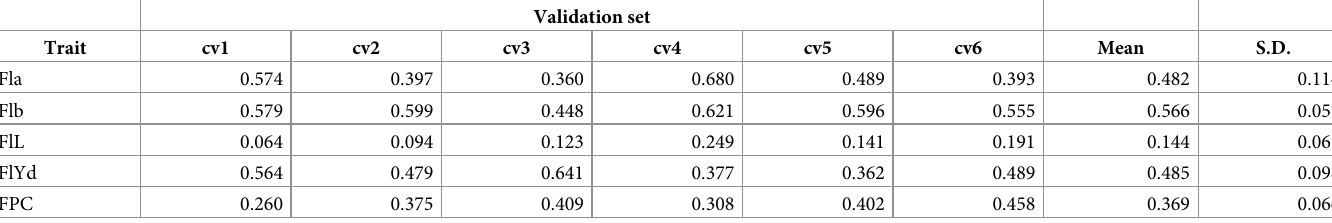
Table 5. Correlation coefficients between predicted and observed values obtained by six-fold cross-validation.